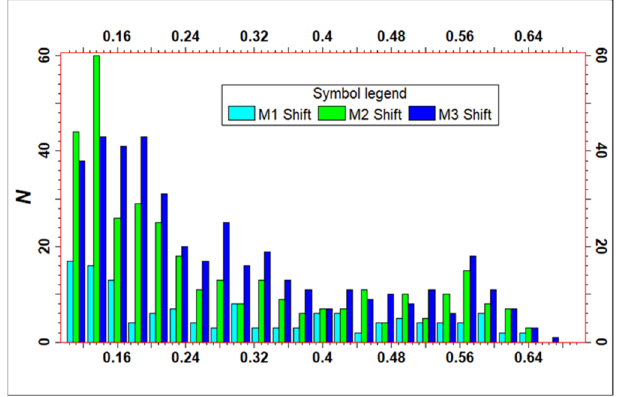
Figure 19. Magnitude distributions of simulated time-lapse depth shifts for monitor survey times M1 (light blue), M1 (green), and M3 (dark blue).